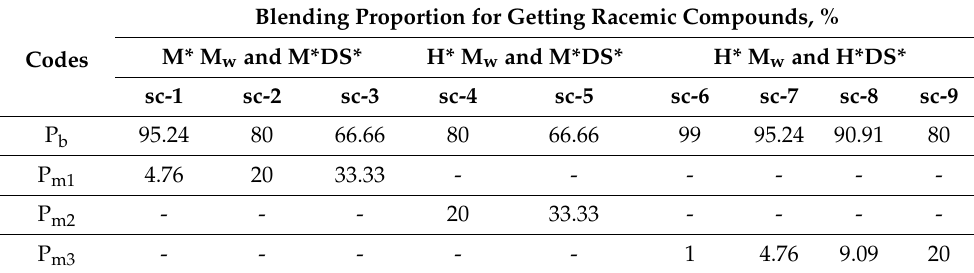
Table 2. The composition of the new stereo-complexed compounds